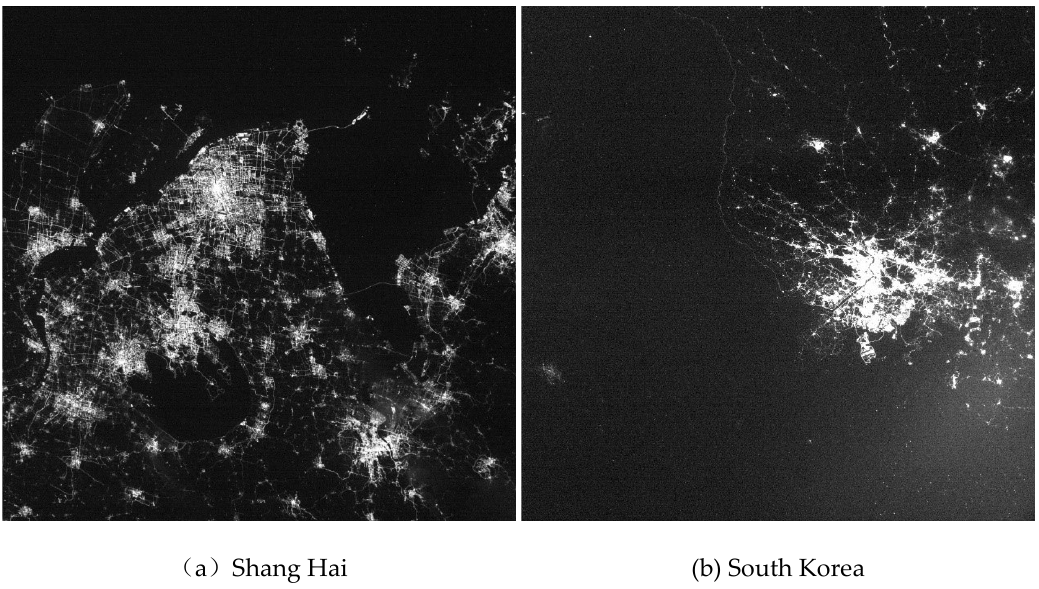
Figure 8. Thumbnails for relative positioning accuracy verification.